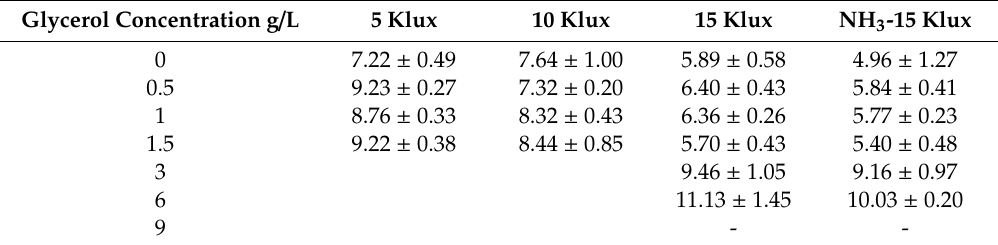
Table 4. Lipids content of A. platensis cultivated under di ff erent glycerol concentrations and light intensities.